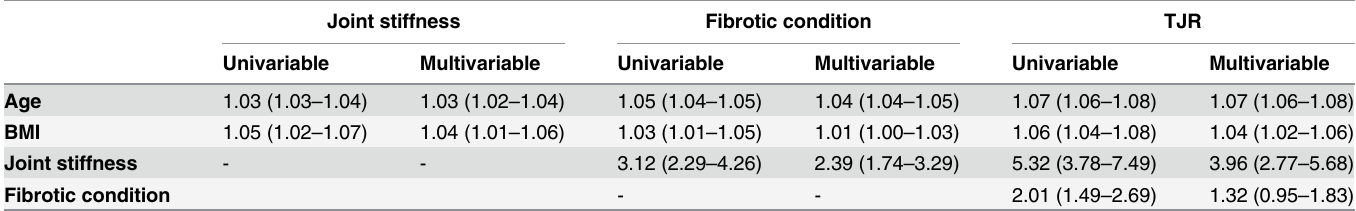
Table 2. Results of uni- and multivariable logistic regression analyses.